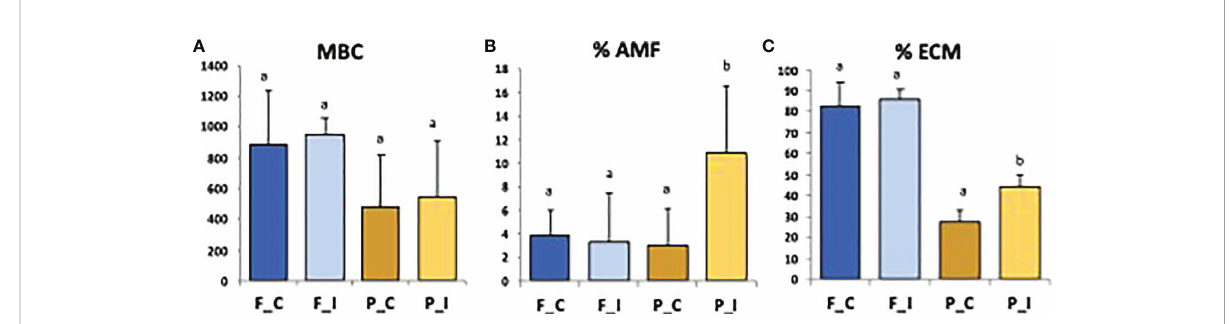
TABLE 3 Richness and diversity indices of the fungal communities from the two sites (Fresnes-sur-Escaut, F; Pierrelaye, P) and two treatments (control, C; inoculated, I).